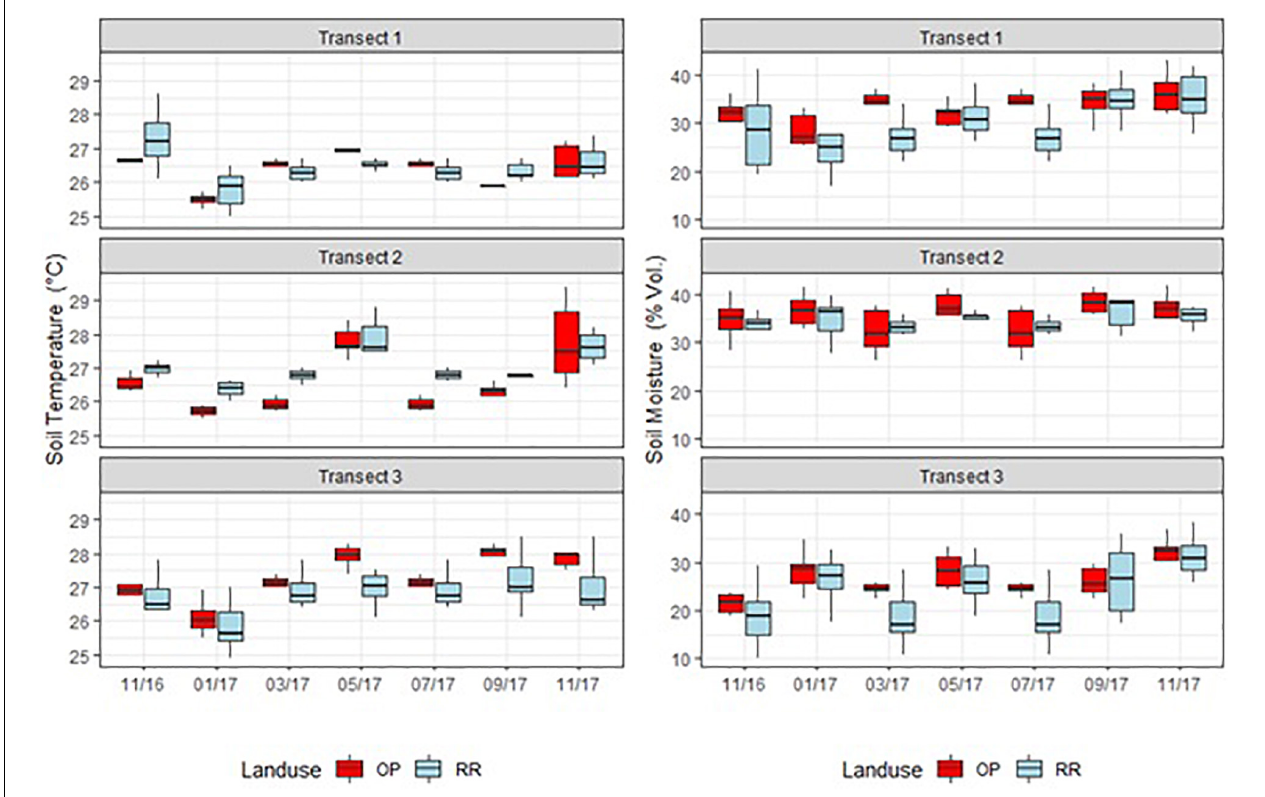
FIGURE 2 | Monthly soil temperature (left) and volumetric soil moisture content (right) from the three transects (1–3), OP, oil palm (red); RR, riparian forest (blue). The lower and upper hinges correspond to the first and third quartiles (the 25th and 75th percentiles), lower whisker = smallest observation greater than or equal to lower hinge –1.5 × IQR (inter quartile range), upper whisker = largest observation less than or equal to upper hinge +1.5 × IQR. The median is marked by a horizontal line inside the